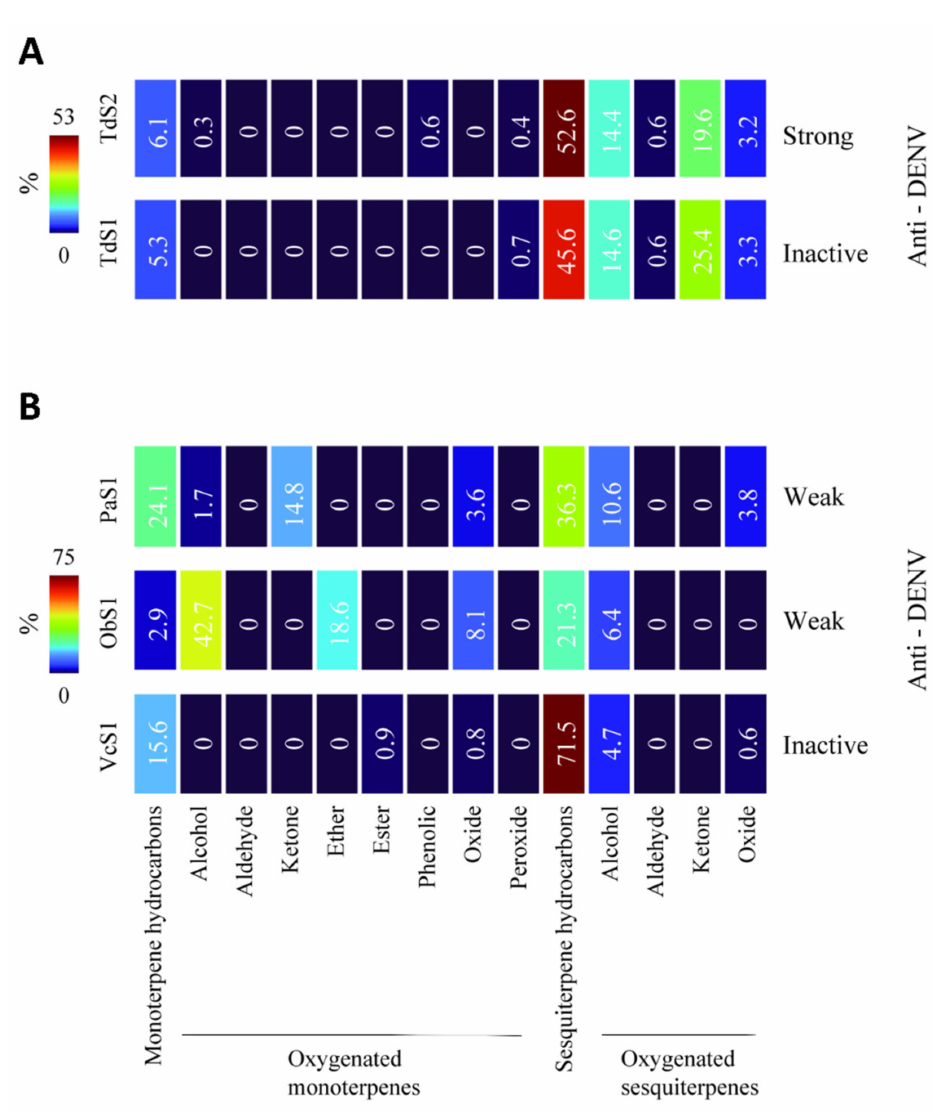
Figure 3. Antiviral activities of essential oils against dengue virus and terpene content. Heat maps representing the chemical composition in monoterpenes and sesquiterpenes types. Antiviral activity (Anti-DENV) was expressed as strong, weak, and inactive (Table 3). ( A ). Neat EOs of T. diffusa collected in 2019 (TdS1) and 2016 (TdS2). ( B ). Neat EOs of O. basilicum (ObS1) P. aduncum ( Pa S1) and V. curassavica